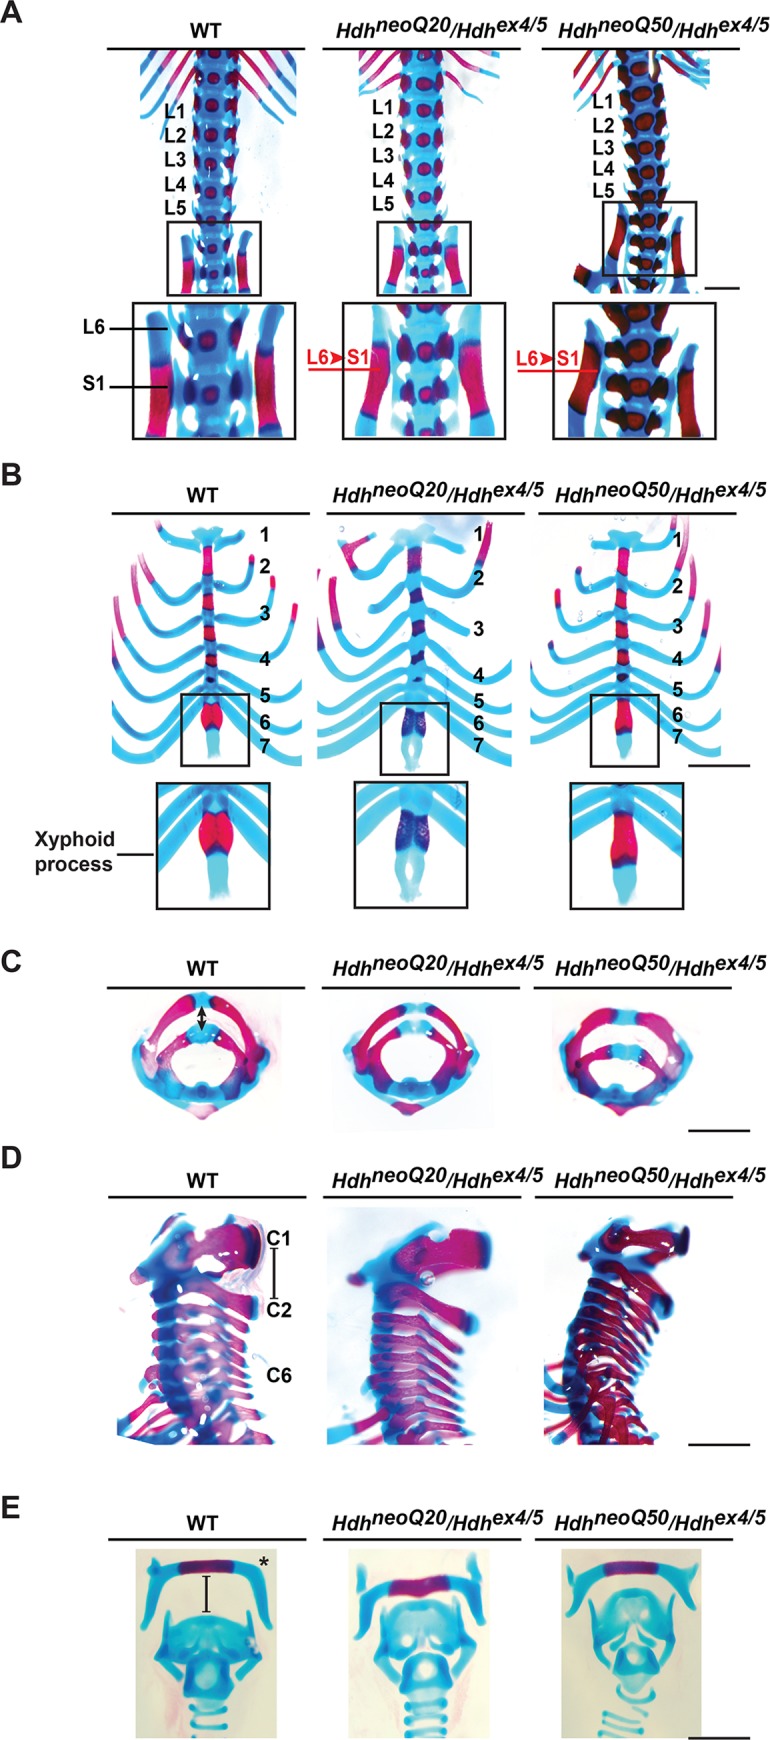
Skeletal defects in HdhneoQ20/Hdhex4/5 and HdhneoQ50/Hdhex4/5 hypomorphic embryos.Representative images of alcian blue and alizarin red-stained skeletal preparations from wild-type (WT), HdhneoQ20/Hdhex4/5, and HdhneoQ50/Hdhex4/5 E 18.5 embryos. A) Lumbar to sacral transformations (L6 to S1) in HdhneoQ20/Hdhex4/5 and HdhneoQ50/Hdhex4/5 embryos, where sacral area with the iliac bones is enlarged in the inset, L1 to L6 indicate lumbar vertebrae, T13 is the 13th thoracic vertebra and skeletal transformation is in red text. B) Defects in the sternum and xyphoid process of HdhneoQ20/Hdhex4/5, HdhneoQ50/Hdhex4/5 mice, enlarged in the insets, showing xyphoid process fenestration in HdhneoQ20/Hdhex4/5 embryos, with thoracic ribs numbered (black text). C-D) Cervical vertebrae defects in HdhneoQ20/Hdhex4/5 and HdhneoQ50/Hdhex4/5 animals, with the latter having an increase in the gap between C1 and C2 vertebrae, seen in horizontal (C) and vertical side (D) views. E) Defects in the morphology [greater horns (*)] and spacing between hyoid bone and cartilage structures, evident in the HdhneoQ50/Hdhex4/5 embryos. Scale bars in (A) and (B) = 1mm; scale bars in (C), (D), (E) = 500μm. See Table 4 for detailed description of the litters and quantitative analysis of the phenotypes.